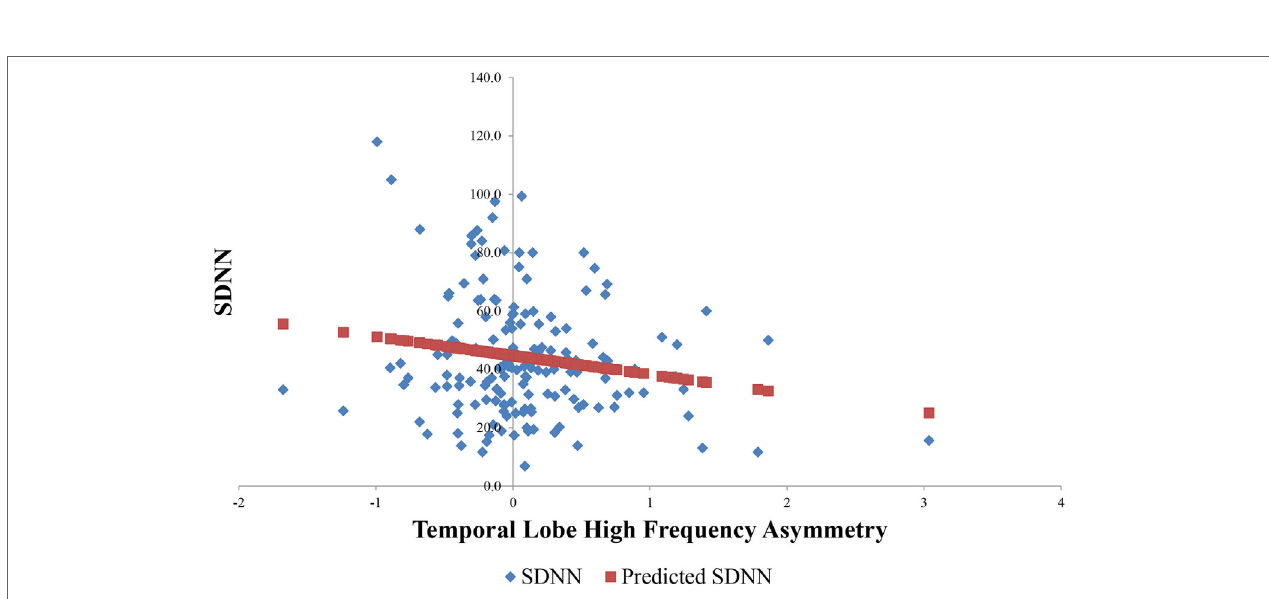
FigUre 5 | Relationship between baseline temporal lobe high frequency (HF) asymmetry and SDNN. Horizontal axis indicates temporal lobe HF asymmetry score, with positive scores indicating rightward asymmetry and negative scores indicating leftward